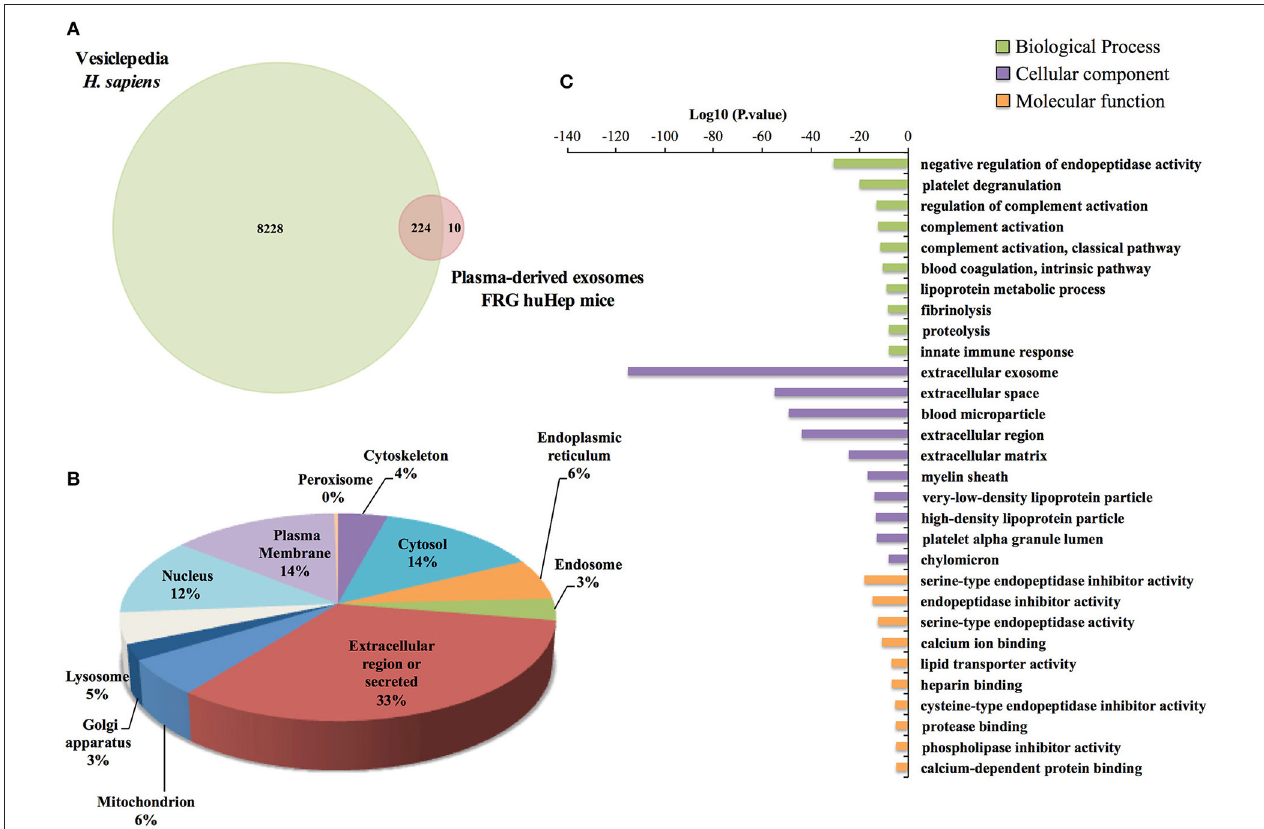
FIGURE 3 | Human Proteome of FRG huHep plasma-derived exosomes. (A) Global analysis of all human proteins identified in EI1 and EI2 shows that of the 234 human proteins identified in the ExEFs from uninfected and P. viv ax infected FRG huHep mice, 224 are reported in Vesiclepedia, a Web-Based repository of extracellular vesicle cargo proteins. (B) Subcellular localization distribution of 234 human proteins groups identified in plasma derived-exosomes from uninfected and P. vivax infected mice. Subcellular compartment was assigned based on GO terms in the UniProt database. (C) Functional enrichment analysis of the top ten more significant Gene ontology (GO) terms of human proteins group enriched in exosomes derived from plasma of uninfected and P. vivax infected FRG huHep mice ( P-value 0.001). Bar plot shows biological process, cellular component, and molecular function GO categories. isoforms of the Merozoite surface protein 3 family